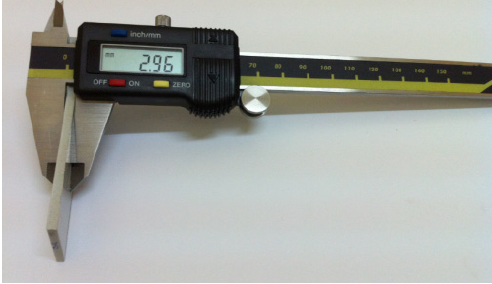
Fig. 2. Measurement of test sample dimensions by calliper.